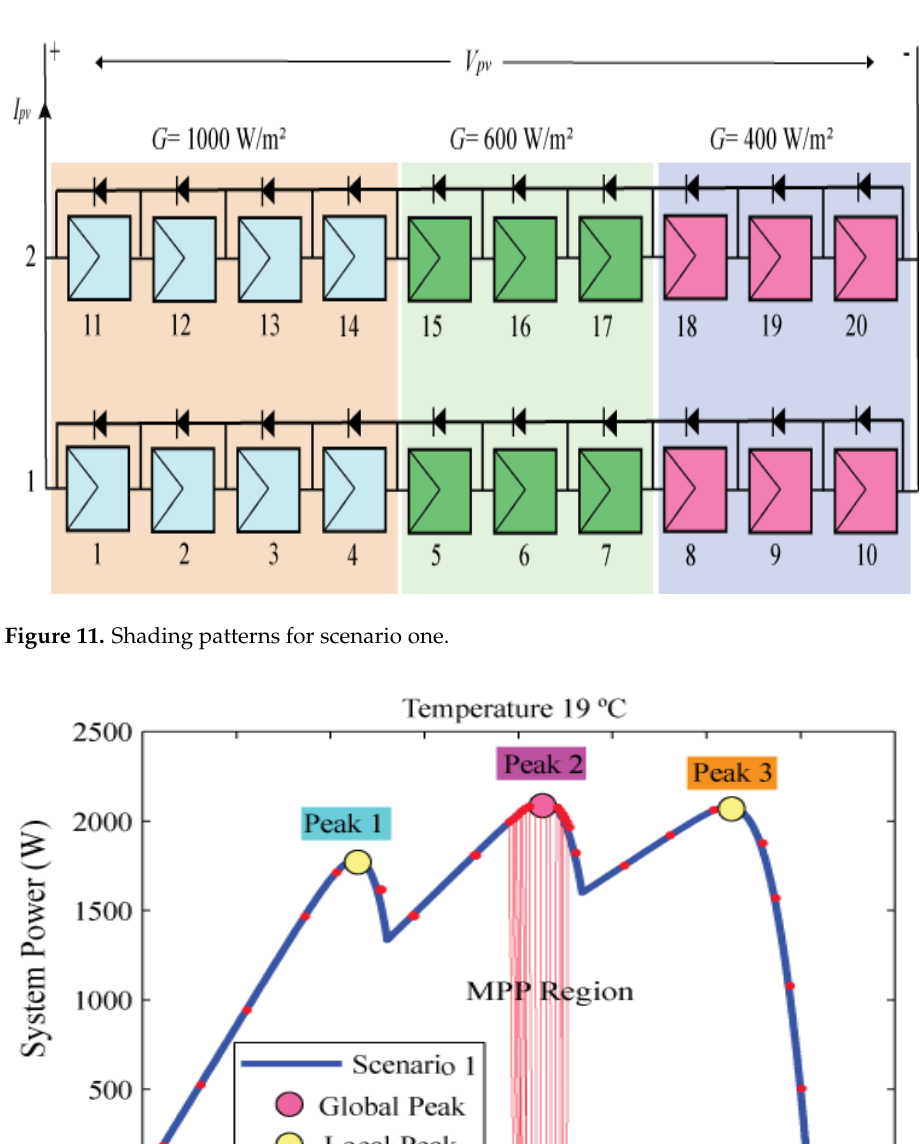
( b ) Figure 13. Details of the duty cycle and power of proposed CSA-PID, CSA, MPSO, PSO, and MP&O controllers under scenario one. ( a ) The output power of proposed CSA-PID, CSA, MPSO, PSO, and MP&O. ( b ) The output duty cycle of proposed CSA-PID, CSA, MPSO, PSO, and MP&O.